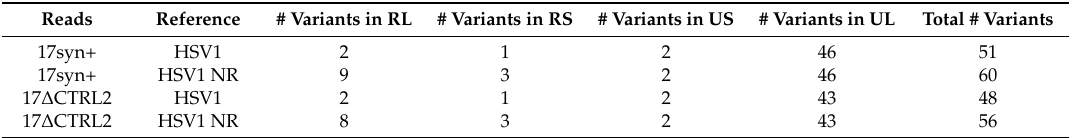
Table 3. The number of variants depends on reference construction. Using a non-redundant reference (HSV1 NR) increases the number of variants identified.